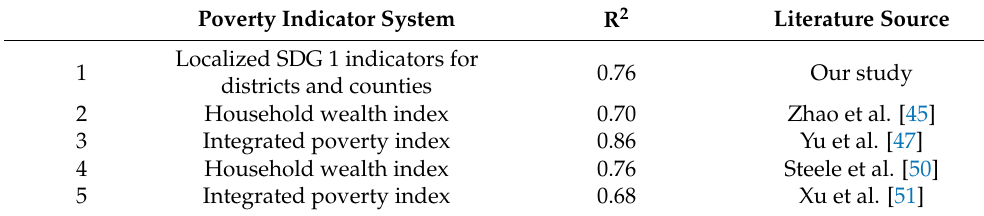
Table 6. Estimated results of related poverty